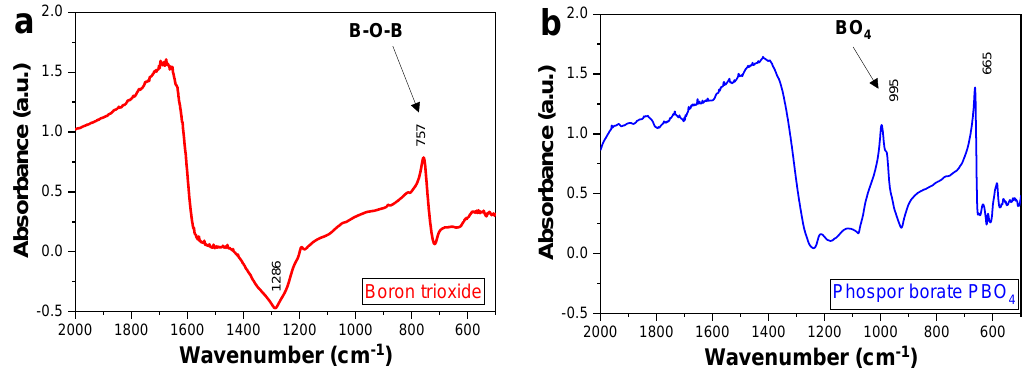
Figure 1. FTIR spectra for ( a ) glassy boron trioxide and ( b ) glassy phosphor borate (PBO 4 ).